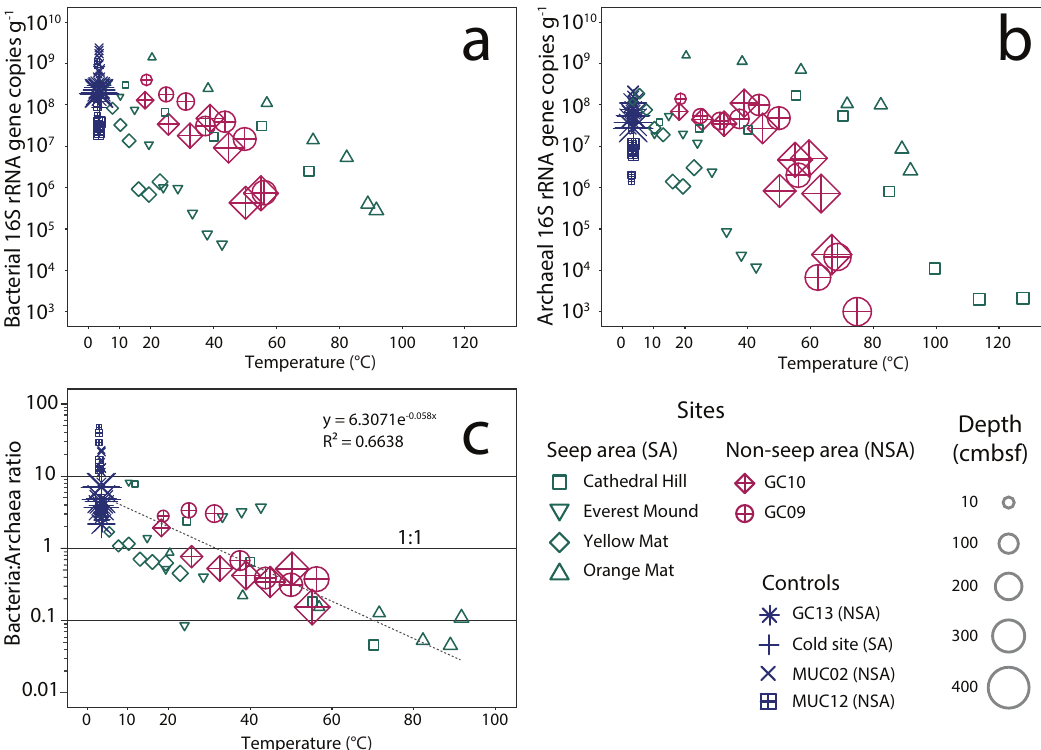
Fig. 4 Gene copy trends in relation to temperature. a Bacterial and ( b ) archaeal 16S rRNA gene copy numbers vs. temperature. c Bacteria-to-Archaea 16S rRNA gene copy ratios vs. temperature (the exponential function and its coef fi cient of determination ( R 2 ), both calculated in Microsoft Excel, are shown in the graph). Symbol sizes indicate the sediment depth of each sample. Cold control sites from both locations are grouped together in the legend for easier viewing.